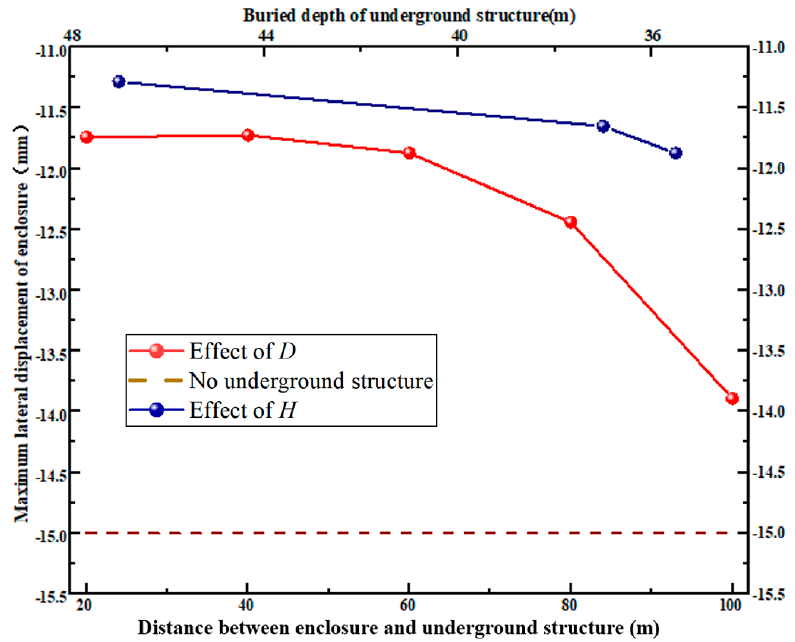
Figure 12. Influence of D and H on maximum enclosure